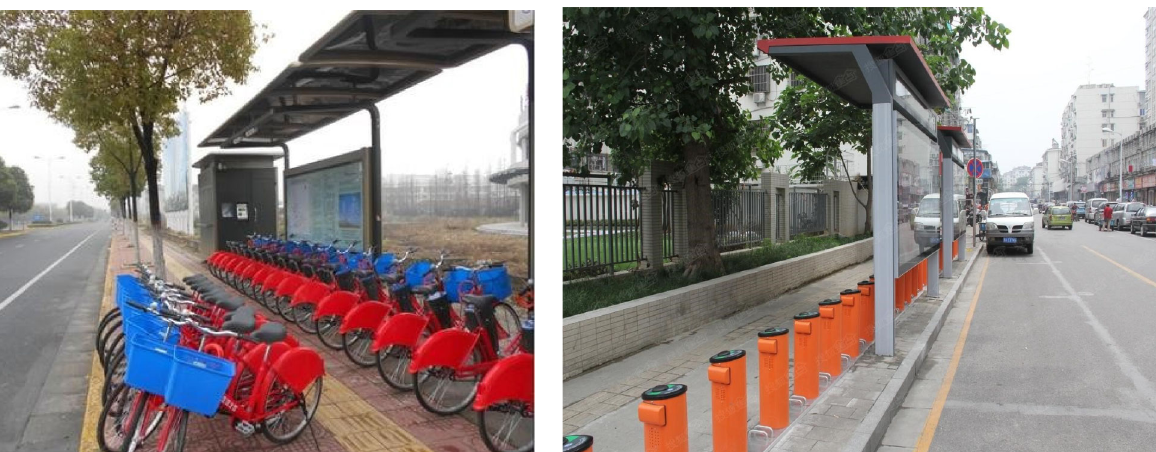
Fig. 1 Unbalanced distribution of shared